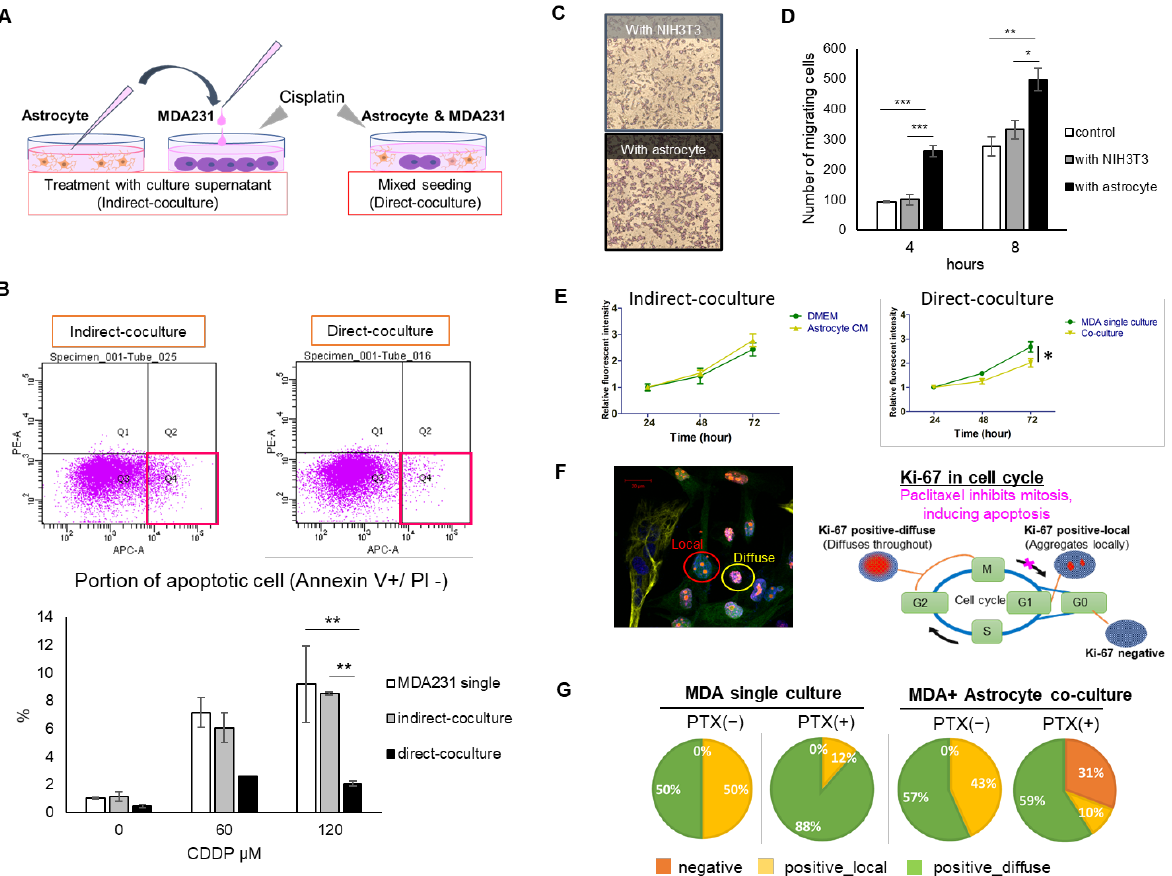
Figure 1. Effect of astrocyte coculture on MDA231 malignant phenotype. ( A ) Two types of cocultures were attempted: treatment with astrocyte culture supernatant (indirect coculture) and mixed seeding (direct coculture). Apoptosis introduced by cisplatin into MDA231 was examined by flow cytometry after coculture. ( B ) Quantitative results of the population of early apoptosis (Annexin V-positive, PI-negative) in CDDP 120 µ M group, represented by the position of the red square in A. Shows PE-A, propidium iodide (PI) staining area, late apoptosis markers. Shows APC-A, Annexin V staining area, early apoptosis markers. Data are expressed as mean ± SD (n = 3, except for 60 µ M direct coculture; n = 2). ** p < 0.01, Tukey–Kramer test. ( C ) Cells were migrated via a Boyden chamber insert with NIH3T3 or astrocytes in the lower well. ( D ) The average number of cells migrated in the observed field. Data are expressed as mean ± SEM (n = 3). * p < 0.05, ** p < 0.01, *** p < 0.001, Tukey–Kramer test. ( E ) Cell viability measured by the fluorescence intensity of enhanced